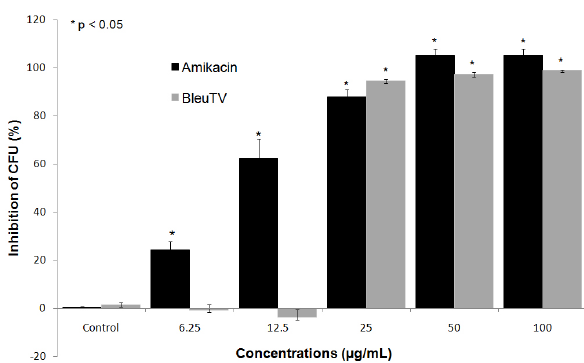
Figure 3. Profiles of the inhibition of S. aureus by B. leucurus venom and amikacin (100, 50, 25, 12.5 and 6.25 µg/mL). After incubation, bacterial growth was measured spectrophotometrically (490 nm). The values represent the mean ± SEM of three independent assays performed in triplicate. *p < 0.05 when compared with the corresponding control group.